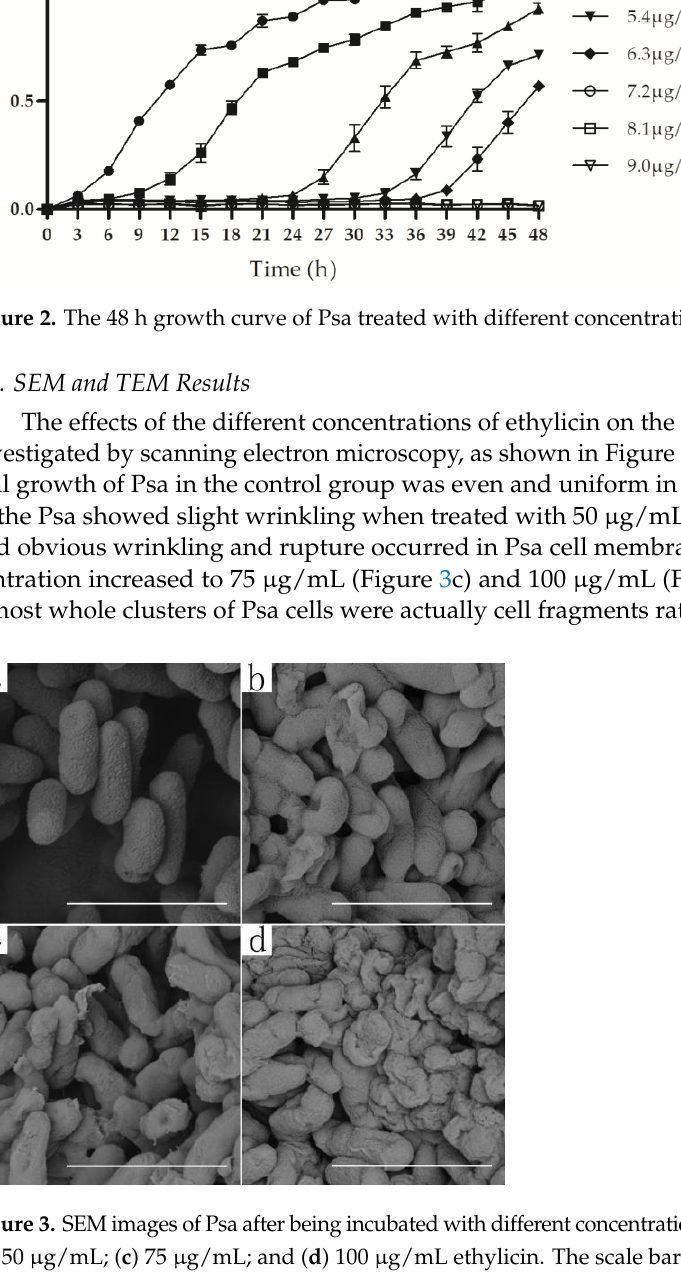
Figure 4. TEM images of Psa after incubation with different concentrations of ethylicin: ( a ) 0 μg/mL; ( b ) 1.80 μg/mL; ( c ) 3.60 μg/mL; and ( d ) 5.40 μg/mL ethylicin. The scale bars for ( a – d ) are 1 μm. 3.4. Effect of Ethylicin on Psa Biofilm Formation and Bacterial Migration